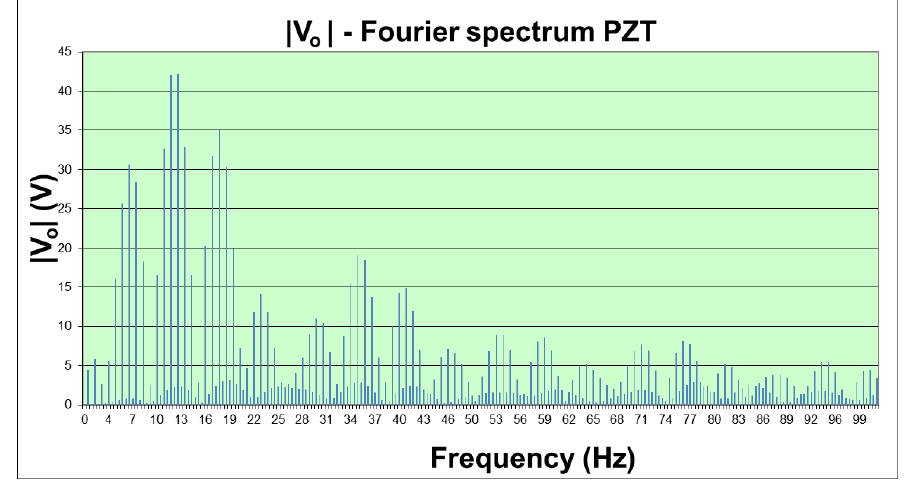
Figure 9. Fourier spectrum modulus of the measured voltage ( V o ) in the PZT ceramics.